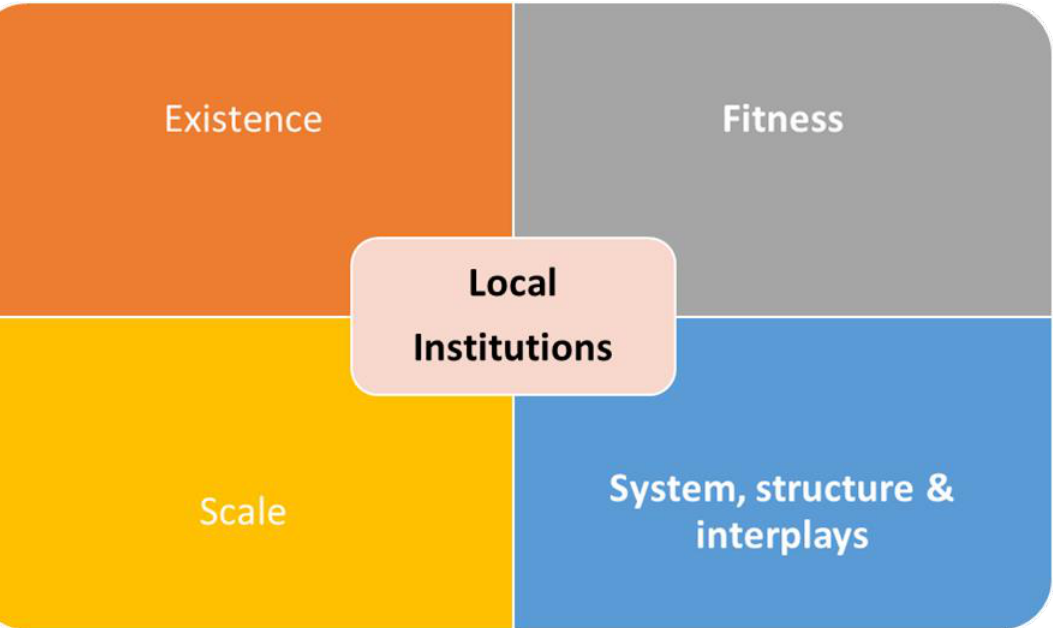
Figure 2. A framework to assess local institutions’ role in adaptation to climate change. Source: modified from [10].